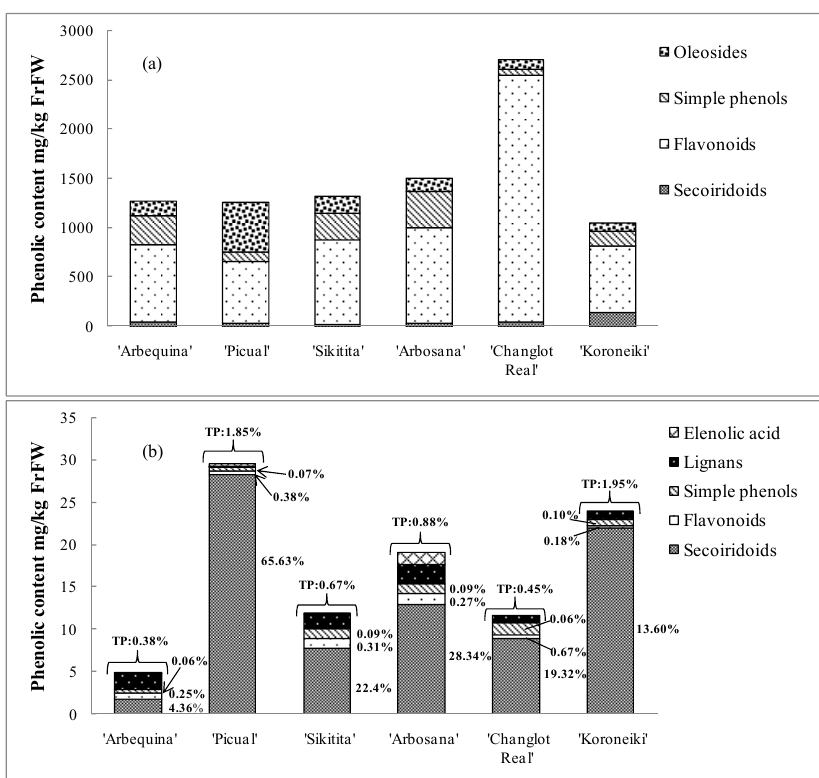
Figure 2. ( a ) Contents of subgroups of phenolic compounds in fruits of various cultivars. ( b ) Contents of subgroups of phenolic compounds in oils produced from the various cultivars. Rates are expressed in % of initial fresh olive fruits phenolic contents (mg/kg fresh fruits weight (FrFW)). TP (total